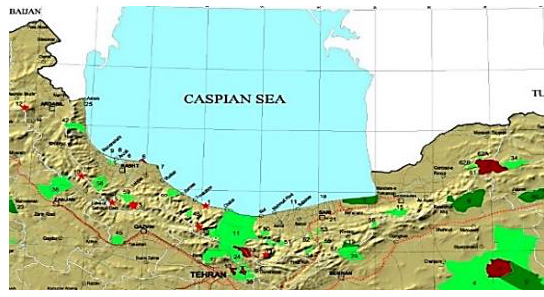
Figure 1. Distribution of studied areas.